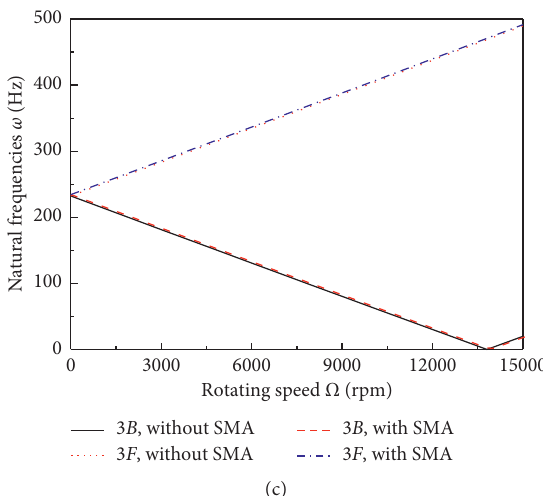
Figure 3: The natural frequencies versus rotating speed of the tapered composite rotating shaft with SMA and without SMA for C-C � 0 . 005): (a) the first mode; (b) the second mode; (c) the third mode. boundary condition ( σ � 0 . 5 , θ � 30 ° ,Vs � 0 . 1 ,T � 50 ° C , ε 0